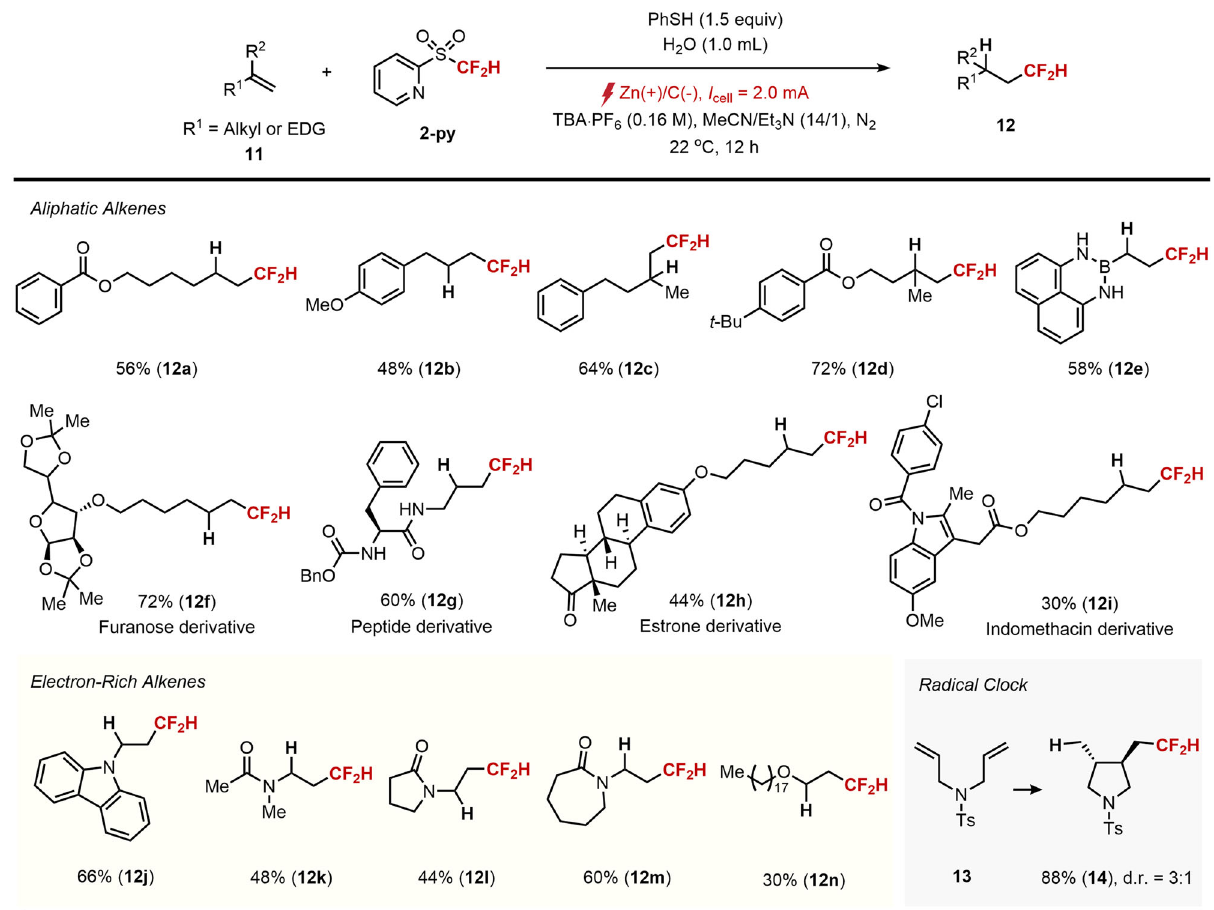
Fig. 6 Substrate scope of aliphatic and electron-rich alkenes a . a 11 (0.2 mmol), 2-py (0.6 mmol), TBA·PF 6 (0.8 mmol) and H 2 O (1.0 mL) in MeCN/Et 3 N (14/1, 4.0 mL) at 22 °C. Isolated yields are reported unless otherwise noted.